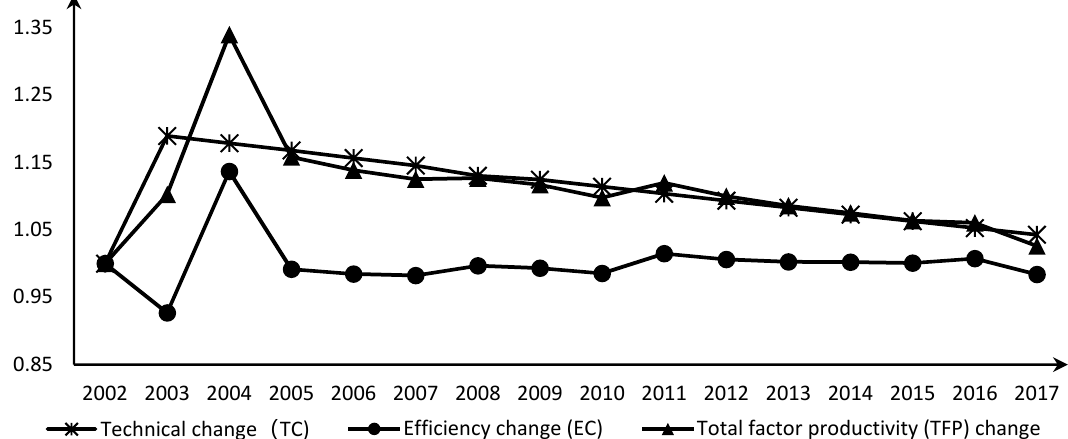
Figure 3. TFP index and its decomposition changes from 2002 to 2017.